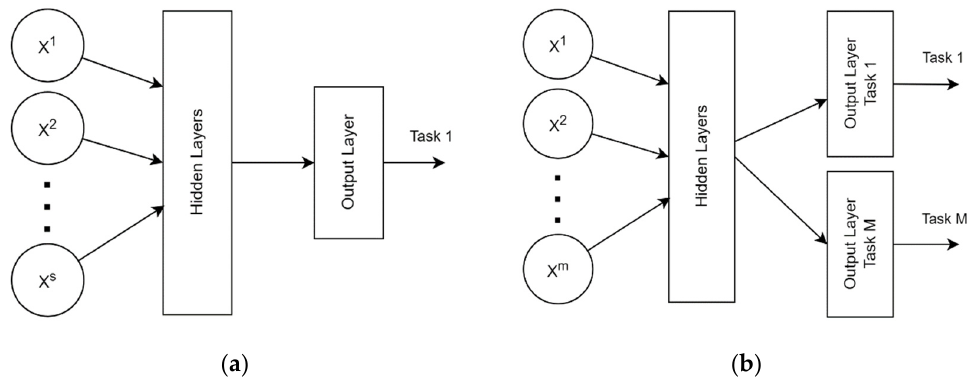
Figure 4. Artificial neural network architecture with ( a ) single-task learning approach; ( b ) multi-task learning approach.